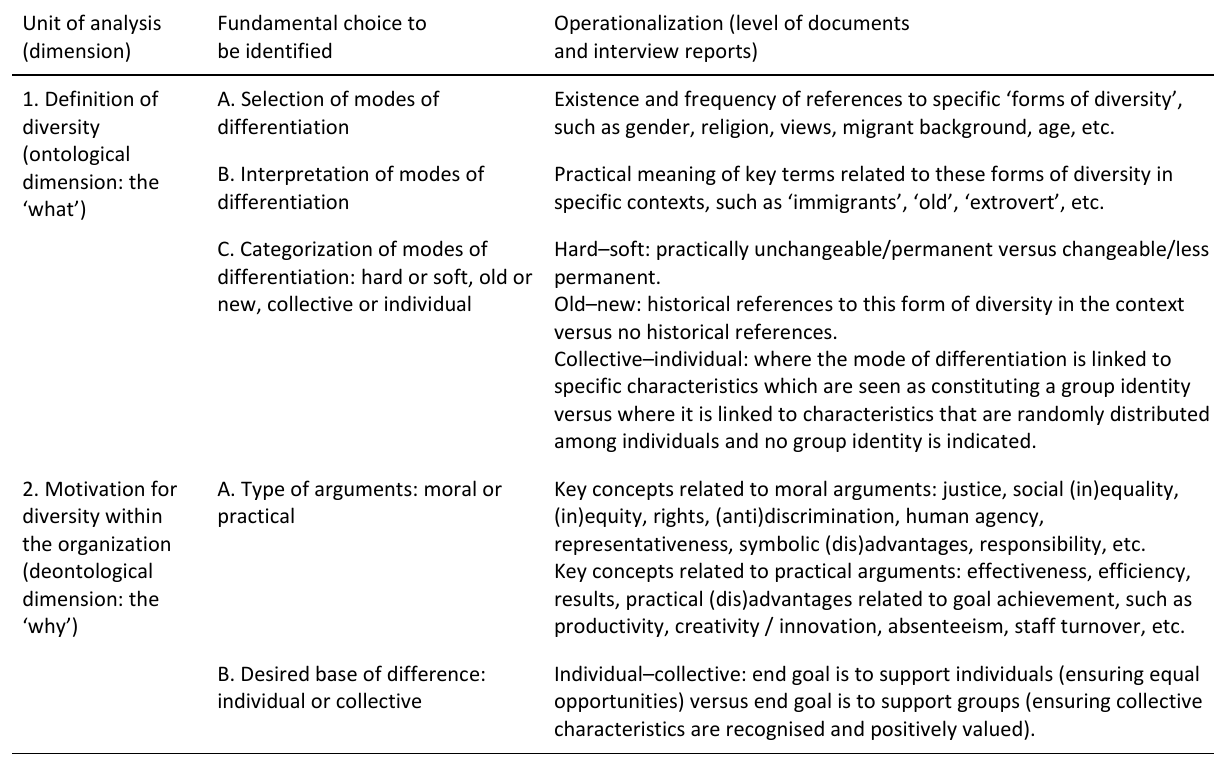
Table 1. Operationalizing the ‘What’ and ‘Why’ of